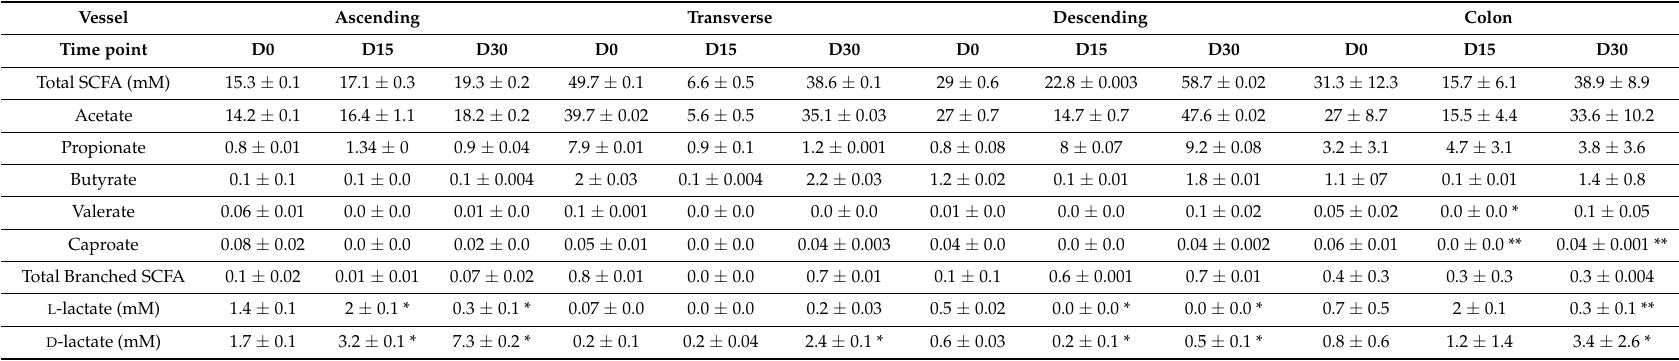
Table 4. Concentrations of SCFA and L - and D -lactate in the colon as a whole and in each individual colon vessel for the control time point (D0) and during the treatment period (D15 and